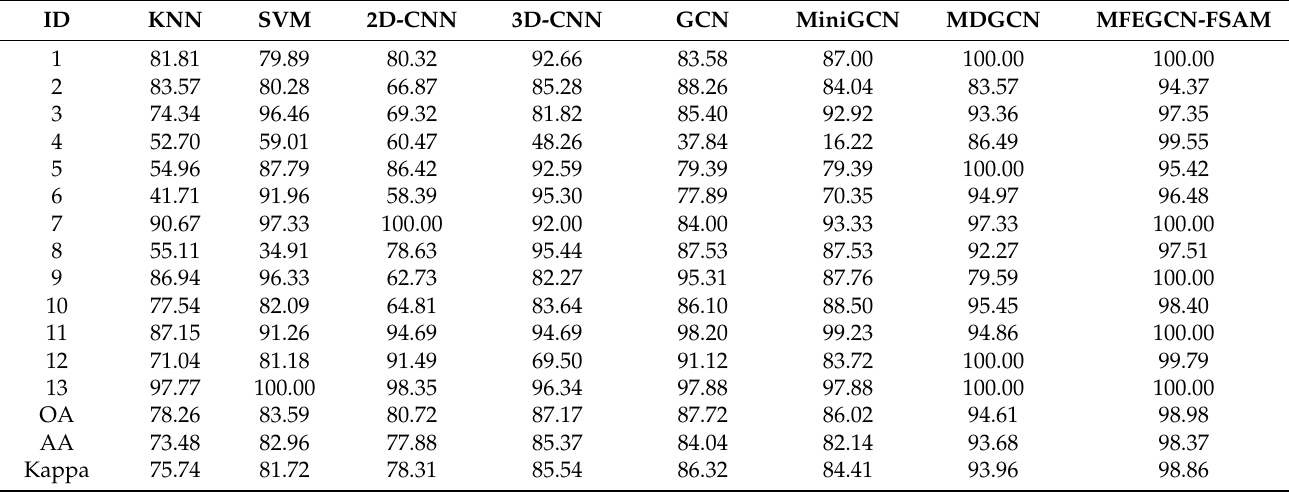
Table 7. Classification performance of different methods on Kennedy Space Center